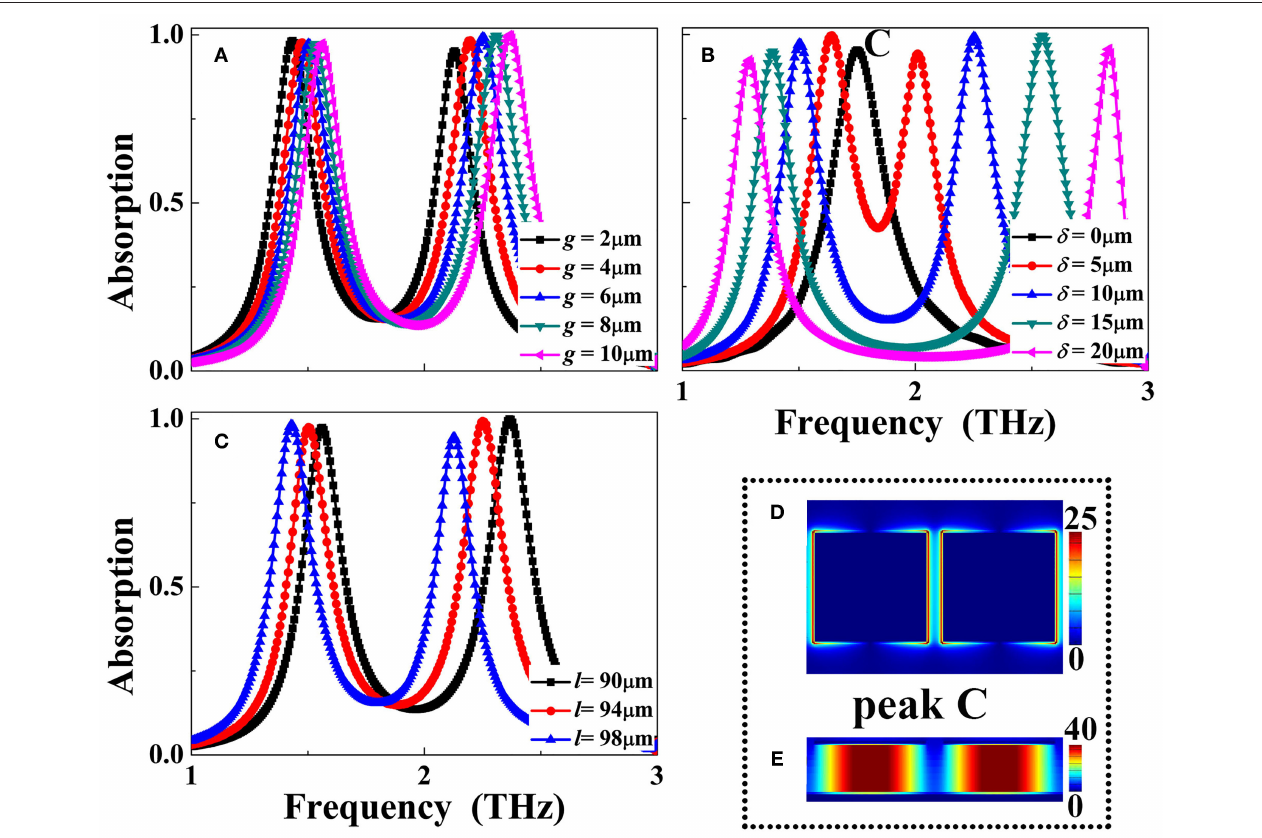
FIGURE 5 | Dependence of the absorption response of the dual-band metamaterial absorber on the size changes of the gap ( g ) in (A) , position ( δ ) in (B) , and rectangular patch length ( l ) in (C) ; (D,E) are, respectively, the electric and magnetic field patterns of the absorption peak C at 1.75 THz.